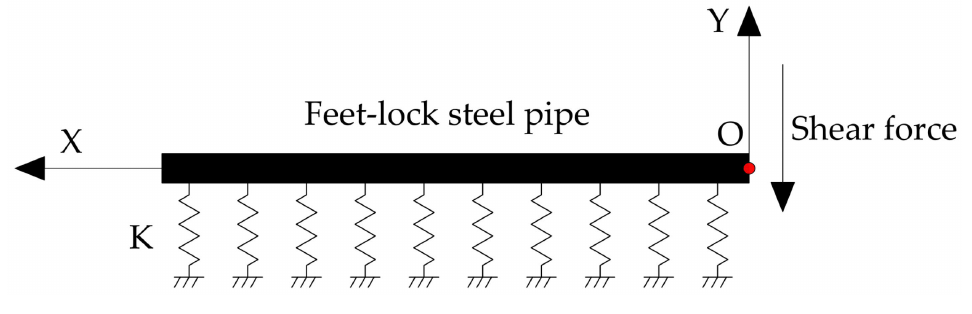
Figure 2. Winkler model of